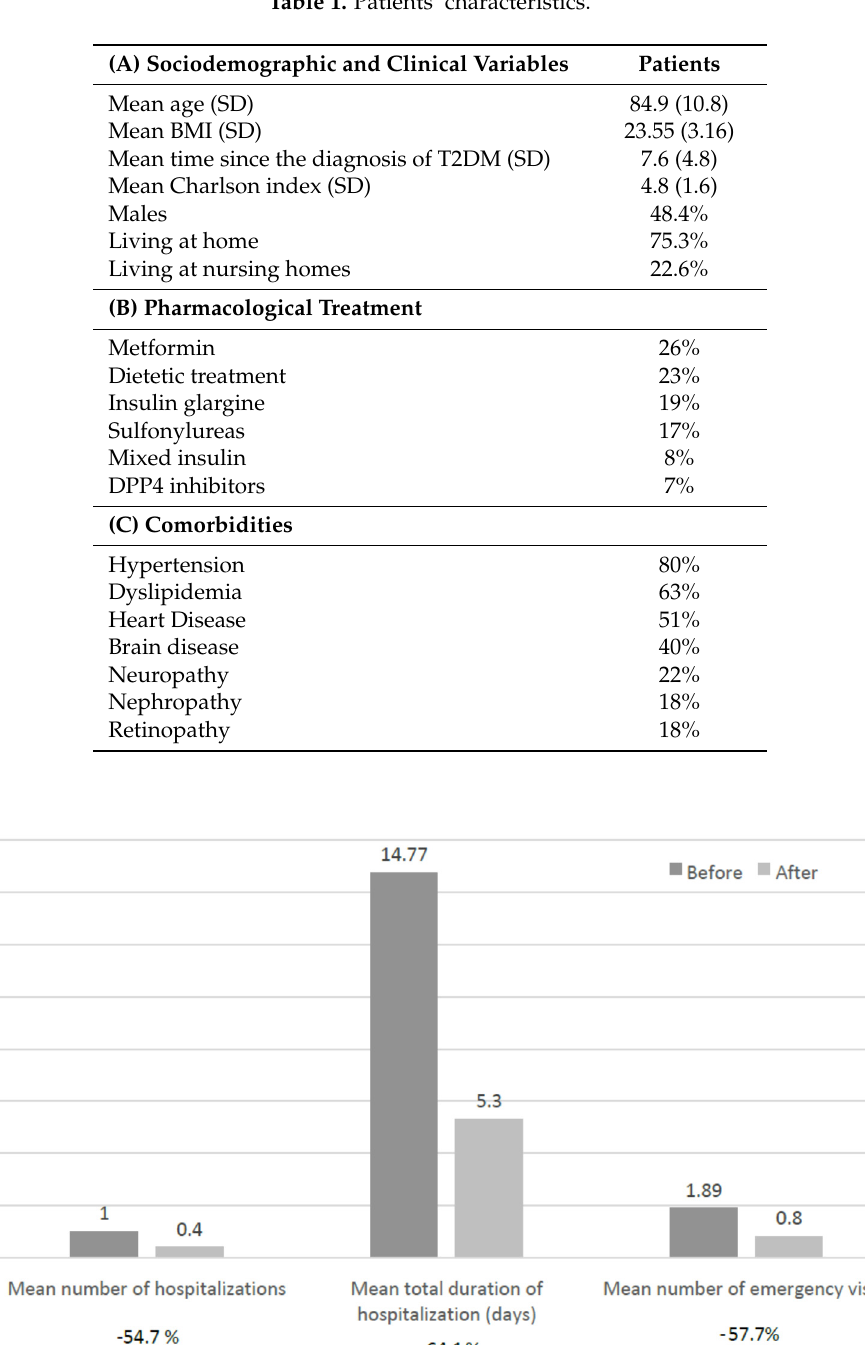
Table 1. Patients’ characteristics.